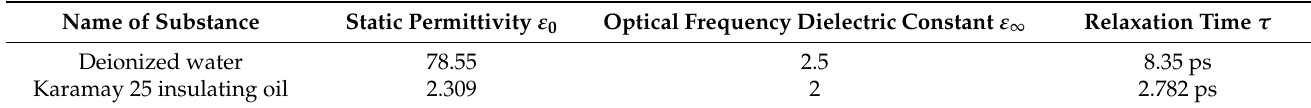
Table 1. Dielectric property value (23.5 ◦ C, at 1